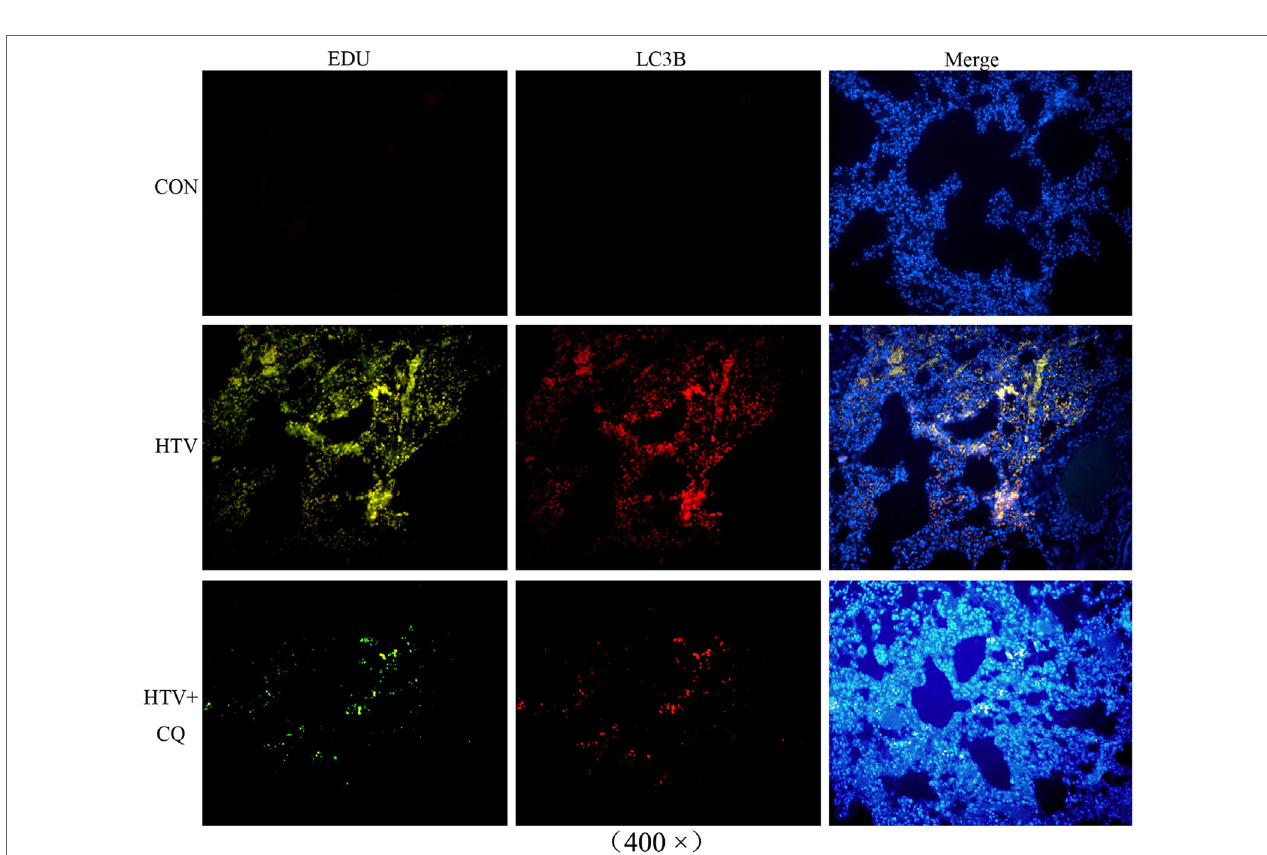
FigUre 5 | Immunofluorescence studies of EdU-labeled mitochondrial DNA (mtDNA) (green) and crucial autophagic protein LC3B (red) in lung tissues from animals with spontaneous breathing (CON) and mechanically ventilated rats pretreated with saline [high tidal volume (HTV)], CQ (HTV + CQ). Immunofluorescence studies confirmed that the EdU-labeled mtDNA (green) was similarly distributed and accumulated with the crucial autophagic protein LC3B, which was labeled with Alexa Fluor 594 (red). Magnification, 400 × . Both of these experiments were in triplicate.